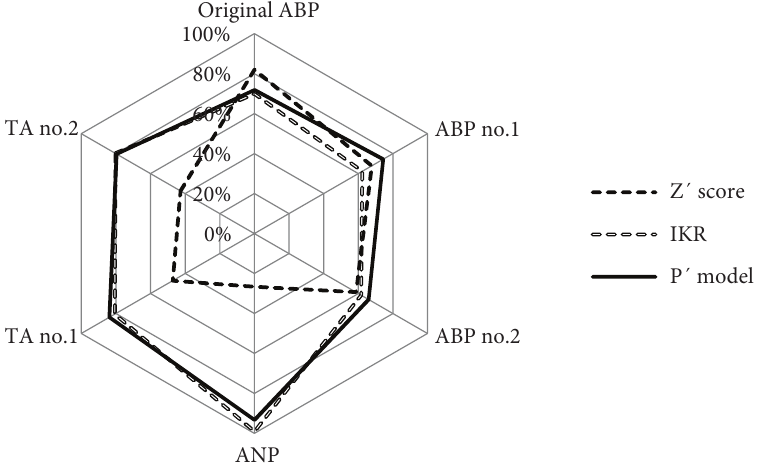
Figure 3. Success of business failure prediction (source: